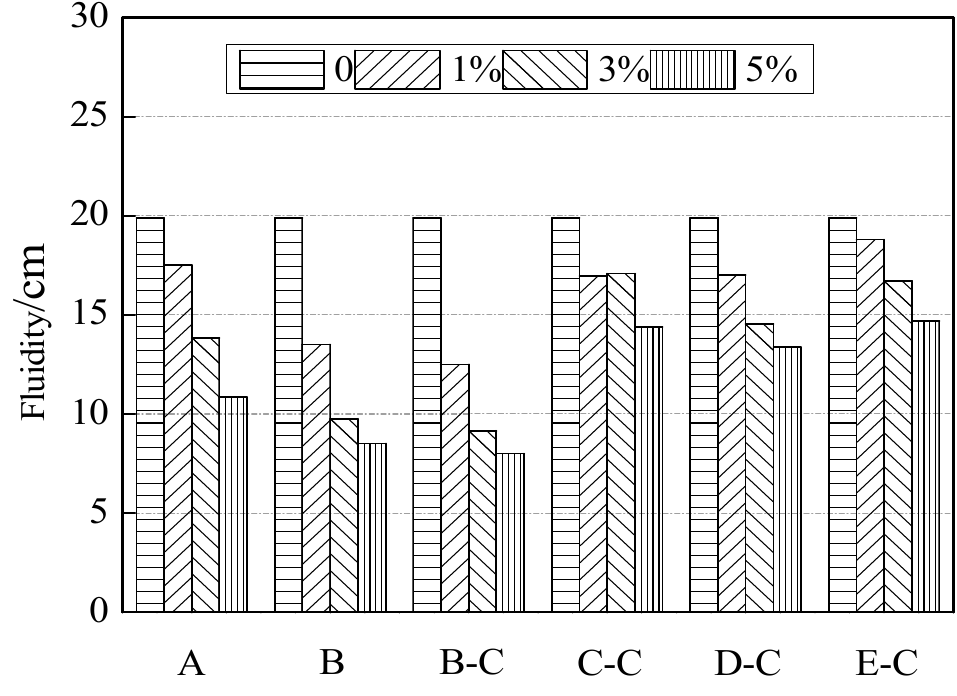
Figure 10. Fluidity of cement mortar with various NAC addition.